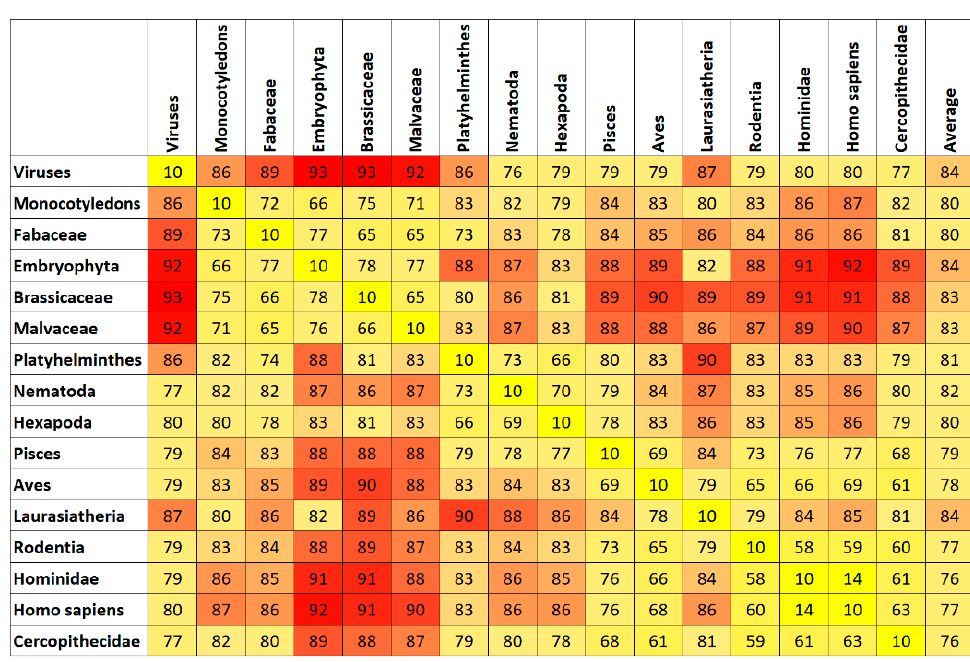
Figure 4. Results in the figure stem from k-mer distance features only. Average accuracy for 100- fold Monte Carlo cross-validation using a random forest classifier and a split of 80% training and 20% testing. Red shades indicate higher average classification accuracy, while yellow shades indicate lower accuracy.